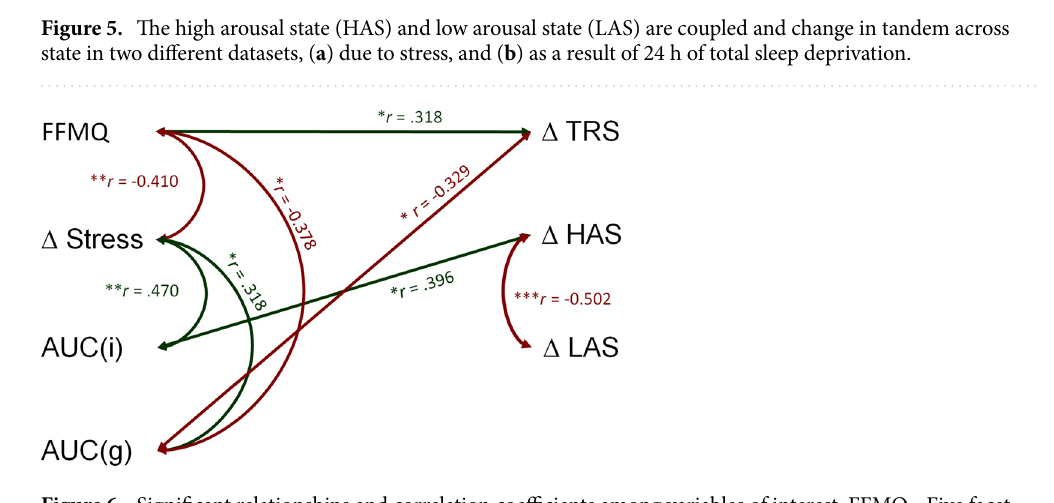
Figure 6. Significant relationships and correlation coefficients among variables of interest. FFMQ = Five facet mindfulness questionnaire, AUCi = increase in area under the curve (cortisol), AUCg = area under the curve with respect to ground (cortisol), TRS = task-ready state, HAS = high arousal state, LAS = low arousal state. * p < .05, ** p < .01, *** p <